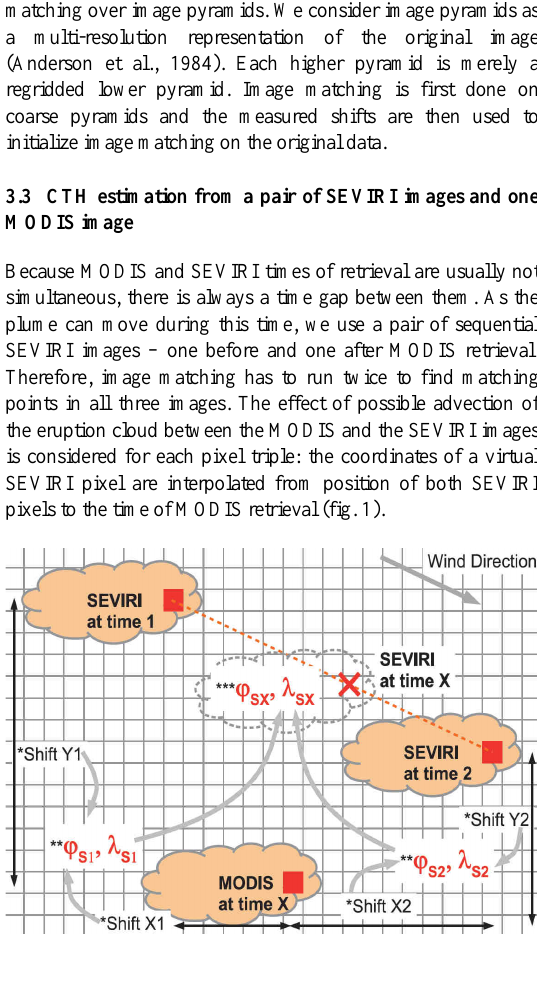
Figure 1. The procedure of determining the position of a cloud in SEVIRI image at the time of MODIS retrieval. * Shifts in column and line direction are estimated twice by automatic image matching between MODIS (retrieved at time X) and SEVIRI (retrieved at times 1 and 2). ** Estimated geographic cloud’s positions are observed by SEVIRI at times 1 and 2. *** Interpolated geographic position of the plume as SEVIRI would observe it at times X corresponding to MODIS